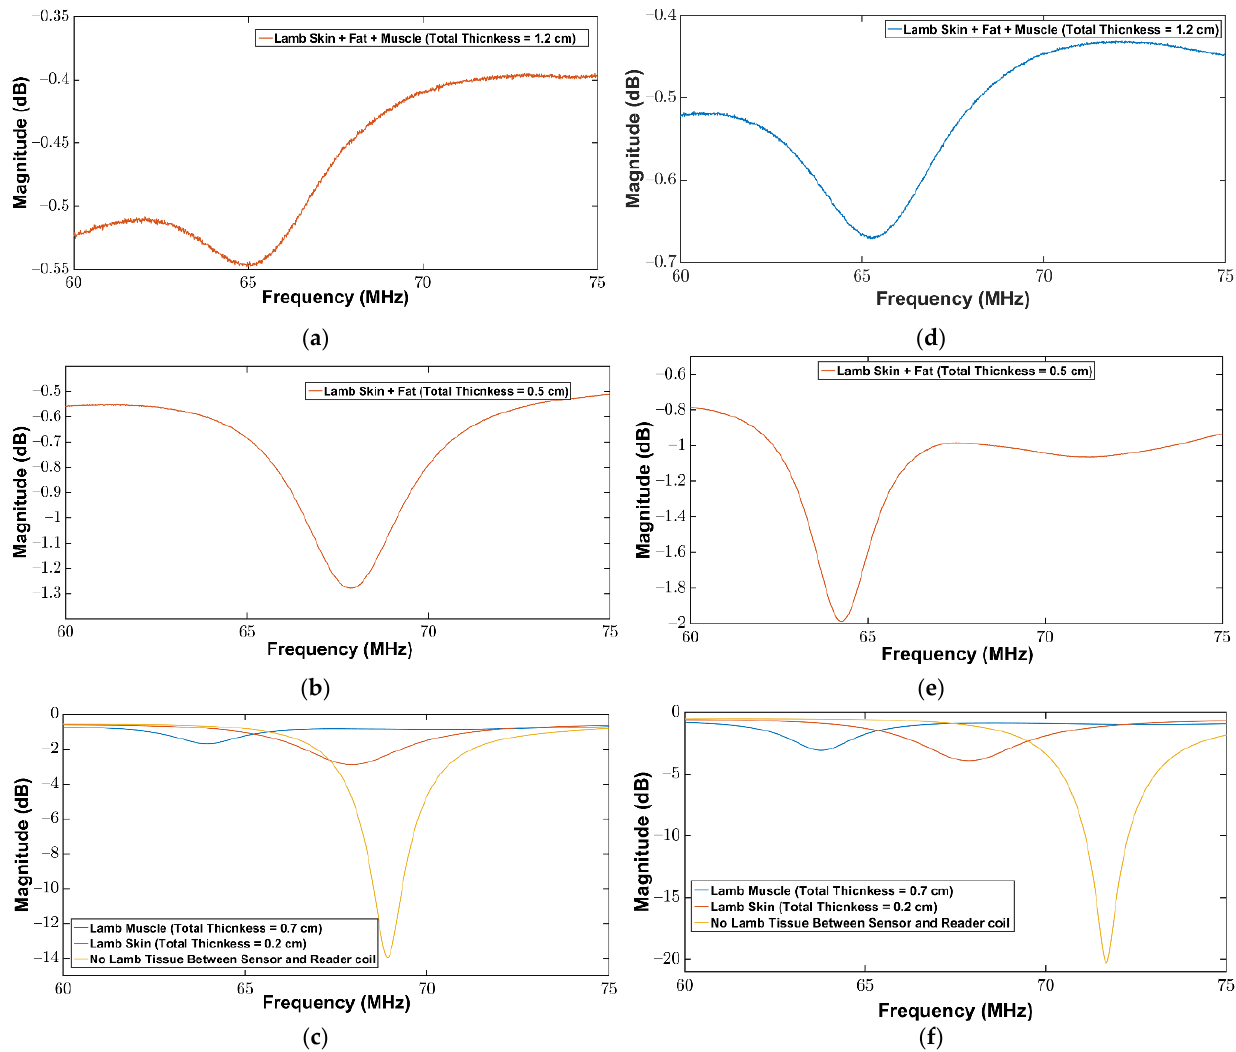
Figure 8. Magnitude of return loss ( 𝑆 11 ) as a function of frequency between the sensor and the readout coil for different thicknesses of the ovine tissue layers: ( a – c ) without repeater coil; ( d – f ) with repeater coil.